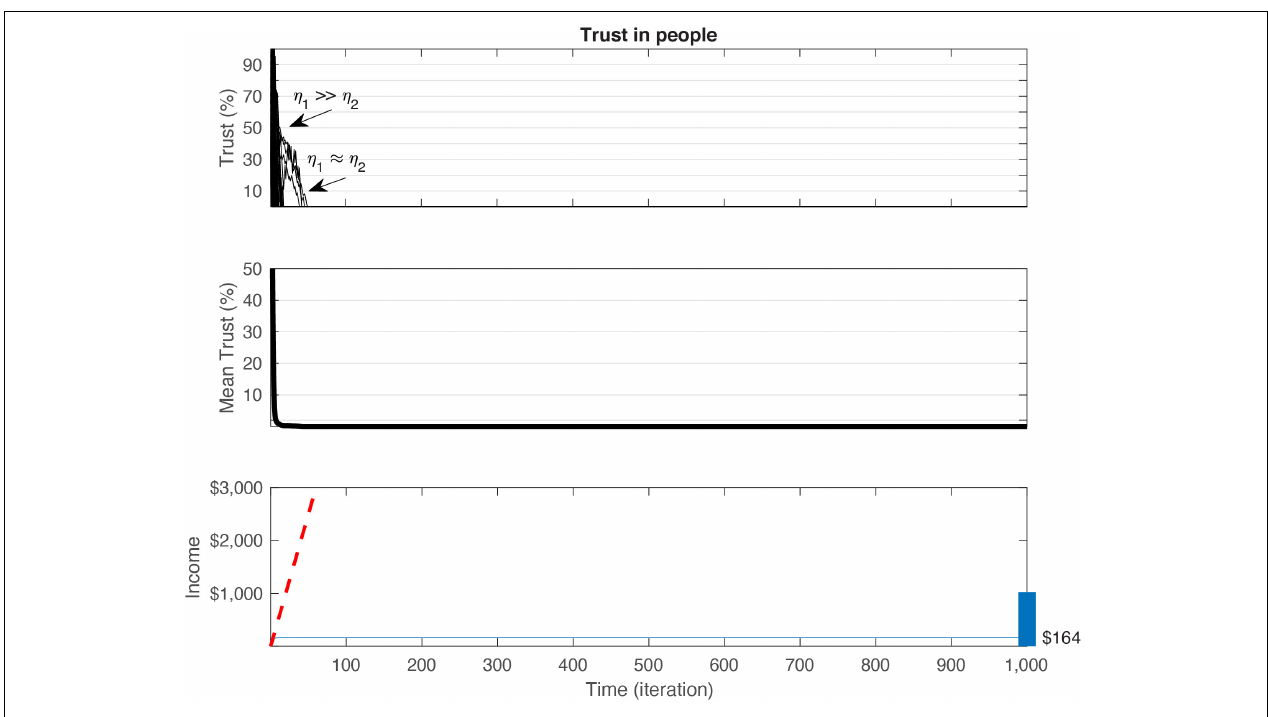
FIGURE 3 | Simulation of regular PG games with varying values for η 1 and η 2 . (Top) across 1,000 iterations, the trust (see equation 2) decays in all games and converges to 0, irrespective of the initial value (iT) and the ratio between η 1 and η 2 . (Middle) Average trust across all games in the top panel. (Bottom) For each of the games and combinations of iT , η 1 , η 2 we calculated the cumulative sum generated by the C-3PO (blue line). While the initial trials typically yield a steady revenue for the C-3PO, once trust breaks and converges to 0 no payoff is received by the C-3PO. Value of $164 correspond to the average scenario where in the first trial all agents contributed to C-3PO ($100 payoff to the C-3PO), followed by a few trials (ranging between 1 to 5 trials) where the income drops because of lower trust by participants, until the payoff decreased to 0 and remains 0 perpetually. Blue bar on the right axis depicts the range of income values generated by the C-3PO across all simulations ($0 – $1,020). Red dashed line marks the optimal cumulative sum if all agents maintained trust throughout the game.